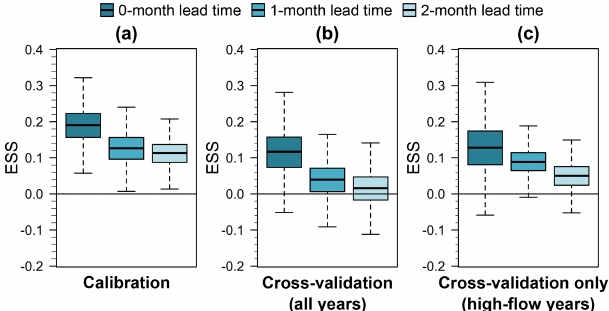
Figure 11. Energy skill score (ESS) distribution for different lead times from the (a) calibration, (b) leave-1-year-out cross-validation, and (c) leave-1-year-out cross-validation for extremes (60th per- centile). Dark turquoise box plots denote a 0-month lead time, turquoise box plots a 1-month lead time, and light turquoise box plots a 2-month lead time. Higher values of the ESS indicate better model performance. Whiskers indicate the 95% credible intervals, boxes the show interquartile range, and the horizontal lines inside the boxes show the median. Outliers are not displayed. All the mod- els consider a Gaussian